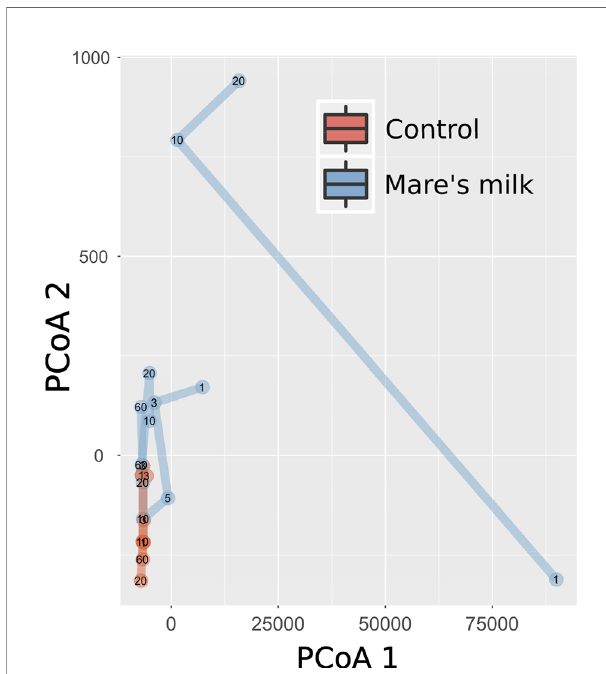
FIGURE 5 | Multivariate analysis of immune shifts. Principal Coordinates Analysis (PCoA) of gut composition (samples post-antibiotic only, replicates not shown) analyzed using Bray-Curtis distances applied to immune measurements. The fi rst two dimensions capturing the data distance space signi fi cantly (PERMANOVA P < 0.001, with parameters in order: intervention, participant identity, and time point) separates mare ’ s milk-treated samples from